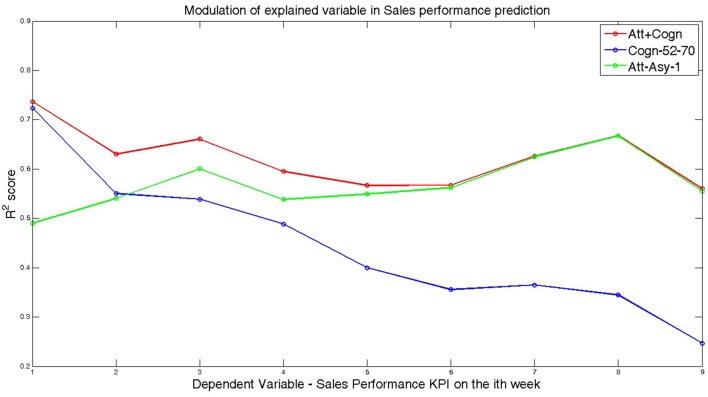
Shows the modulation of the R2 score for the Att-Asy-1, Cogn-52-70 and Att+Cogn models and the nine dependent variables (i.e., sales performance KPI on the movie premiere and the eight following weekends). The model abbreviations are as follows: Att-Asy-1: Attentional-asynchrony metric during the first viewing is used as the independent variable; Cogn-52-70: Cognitive-congruency metric calculated in the frequency range between 52 Hz and 70 Hz is used as the predictor variable; Att+Cogn: The combined predictor model where both the Cognitive-congruency metric calculated on the frequency range 52–70 Hz and the Attentional-asynchrony metric (calculated on measurements from the first viewing) are used as predictor variables.